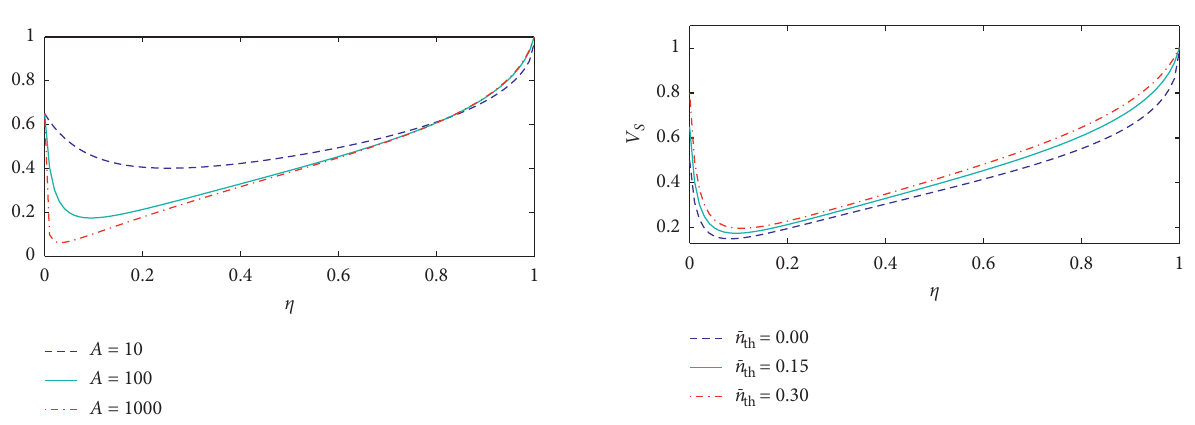
Figure 6: Plots of the smallest eigenvalue V κ � 0 . 8, ε � 0 . 399 and for different values of the linear gain